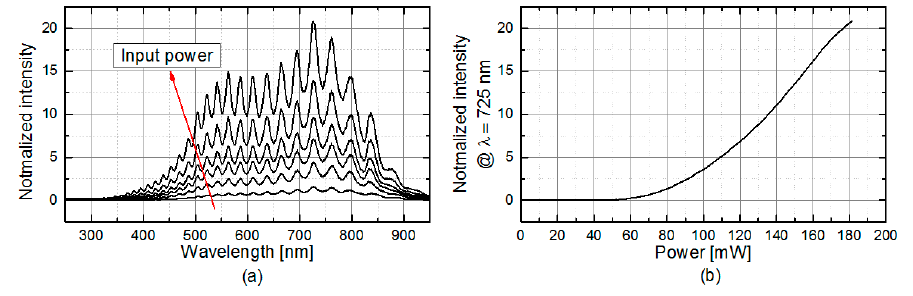
Figure 5. ( a ) Normalized emitted spectrum of structure at different input power, ( b ) normalized intensity at 725 nm wavelength.